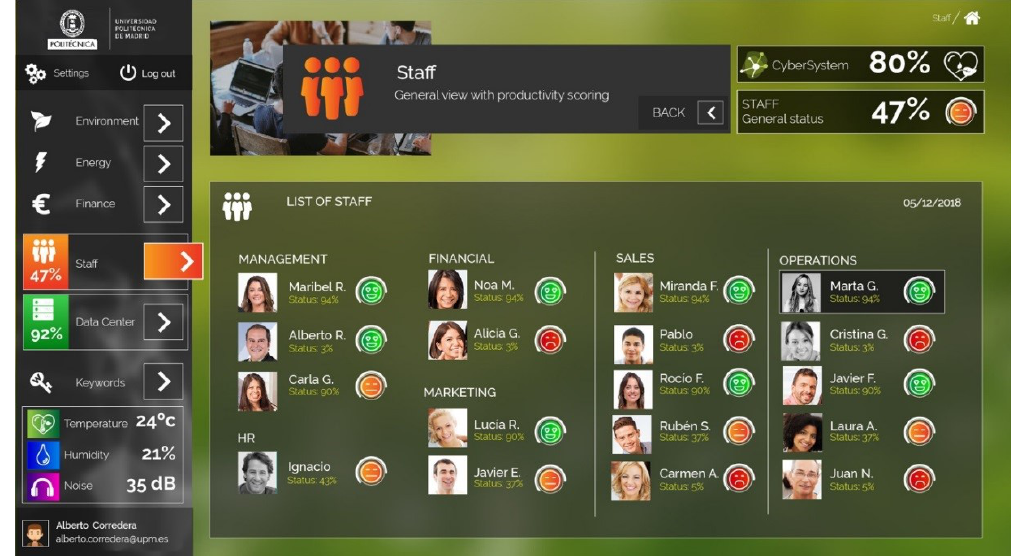
Figure 14. Staff general view from the Management